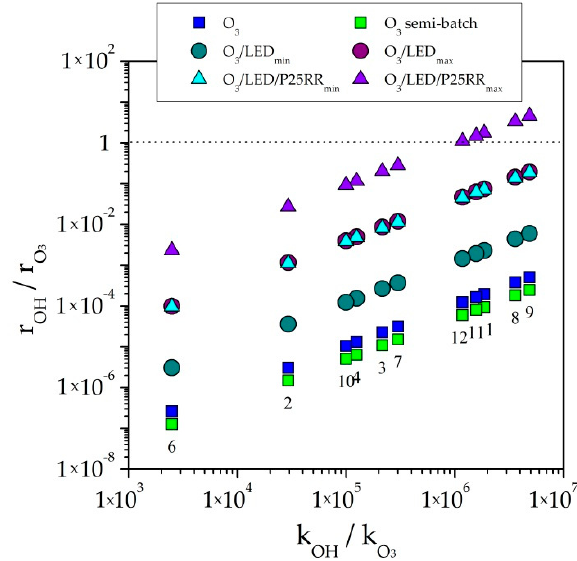
Figure 5. Variation of indirect-direct reaction rate ratio with free radical-direct reaction rate constant ratio with the minimum k L a ( and ) in comparison with the maximum k L a ( and ) and semi- batch mode (O 3 ). See Table 1 for meaning of numbers (Plots based on reference [29]).